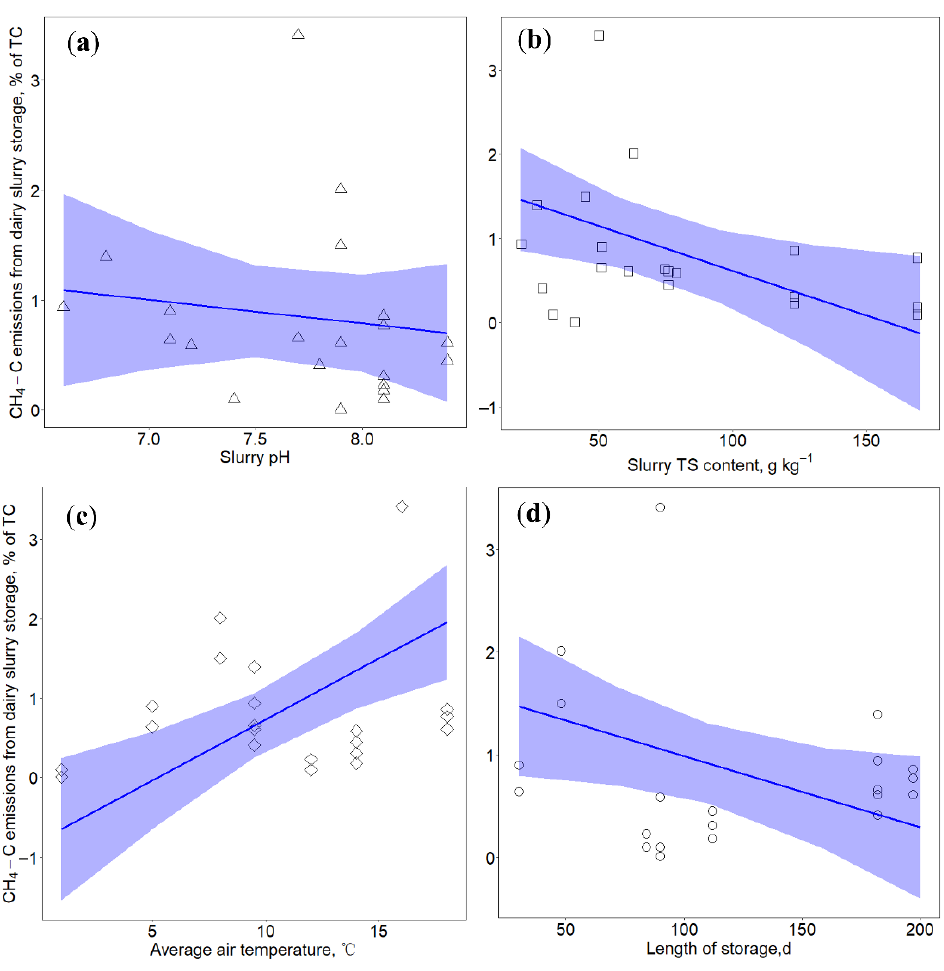
Figure 3. Relationships between CH 4 –C emissions from slurry storage with ( a ) slurry pH (in triangle), ( b ) total solids (TS) content (in square), ( c ) air temperature (in diamond) and ( d ) length of storage (in circle). Blue lines indicate prediction lines based on results of linear mixed effects model: lmer (CH 4 –C ~ pH + TS + T + LOS + (1|Reference)). Blue shadows represent model predicted results with 95% confidence interval.